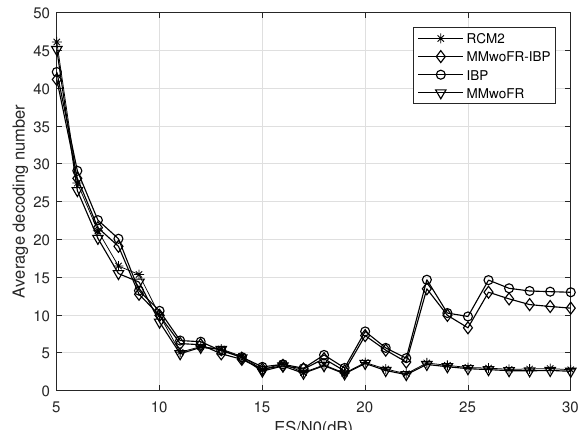
Figure 9. Average decoding number under different SNR with weight set { ± 1, ± 2, ± 4, ± 4 }